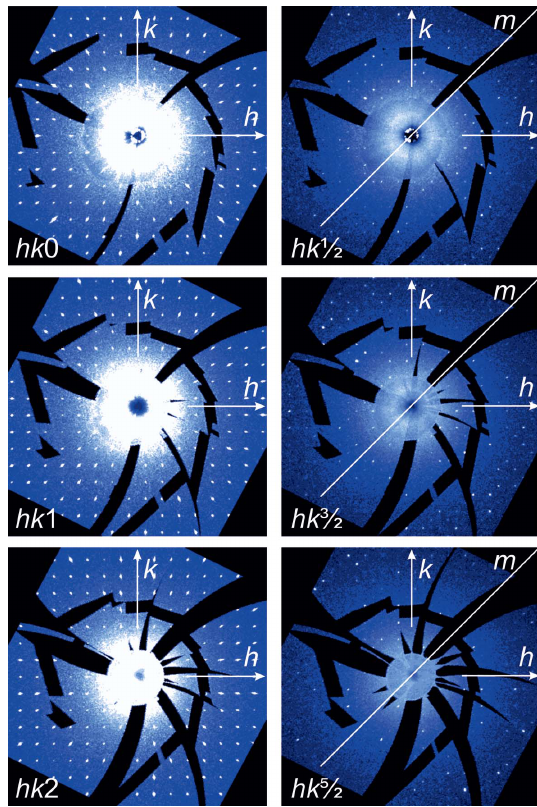
Figure 4 Reciprocal space of the sXRD data measured at 100 K reconstructed in sections perpendicular to c * ( Fd 3 m setting). The image cutouts correspond to (cid:4) 14 (cid:9) h , k (cid:9) 14, each centered at 00 l . The layers hk 0, hk 1 and hk 2 represent only reflections occurring in the cubic parental structure. The weak superstructure reflections (in layers with l = 1/2, 3/2, 5/2, ... only) indicate Laue symmetry 2/ m and twinning (marked by the twin plane m ).